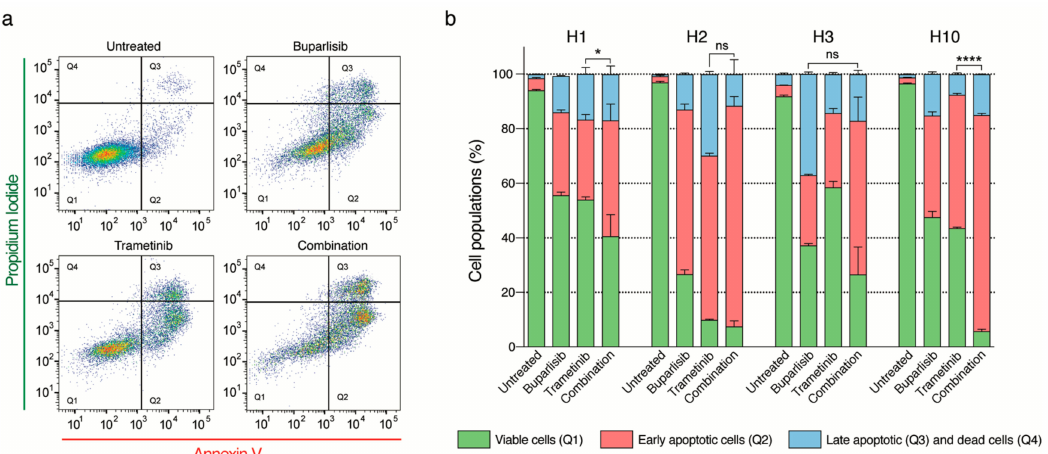
Figure 5. Flow cytometric analysis of apoptosis after treatment of melanoma brain metastasis cells with buparlisib and trametinib. ( a ) Representative dot plots of H1 cells treated with 10 µ M buparlisib, 10 µ M trametinib or combination (5 µ M buparlisib and 5 µ M trametinib). Annexin V labels apoptotic cells, while Propidium Iodide labels necrotic cells. ( b ) Quantification of the percentage of viable, apoptotic and necrotic cells for the H1, H2, H3 and H10 cell lines. The experiments were done in triplicate (n = 3 per experiment per drug concentration). Abbreviations: Q1: viable cells, Q2: cells in early apoptosis, Q3: late apoptotic cells, Q4: necrotic cells, ns: not significant, *: p < 0.05 and ****: p < 0.0001.